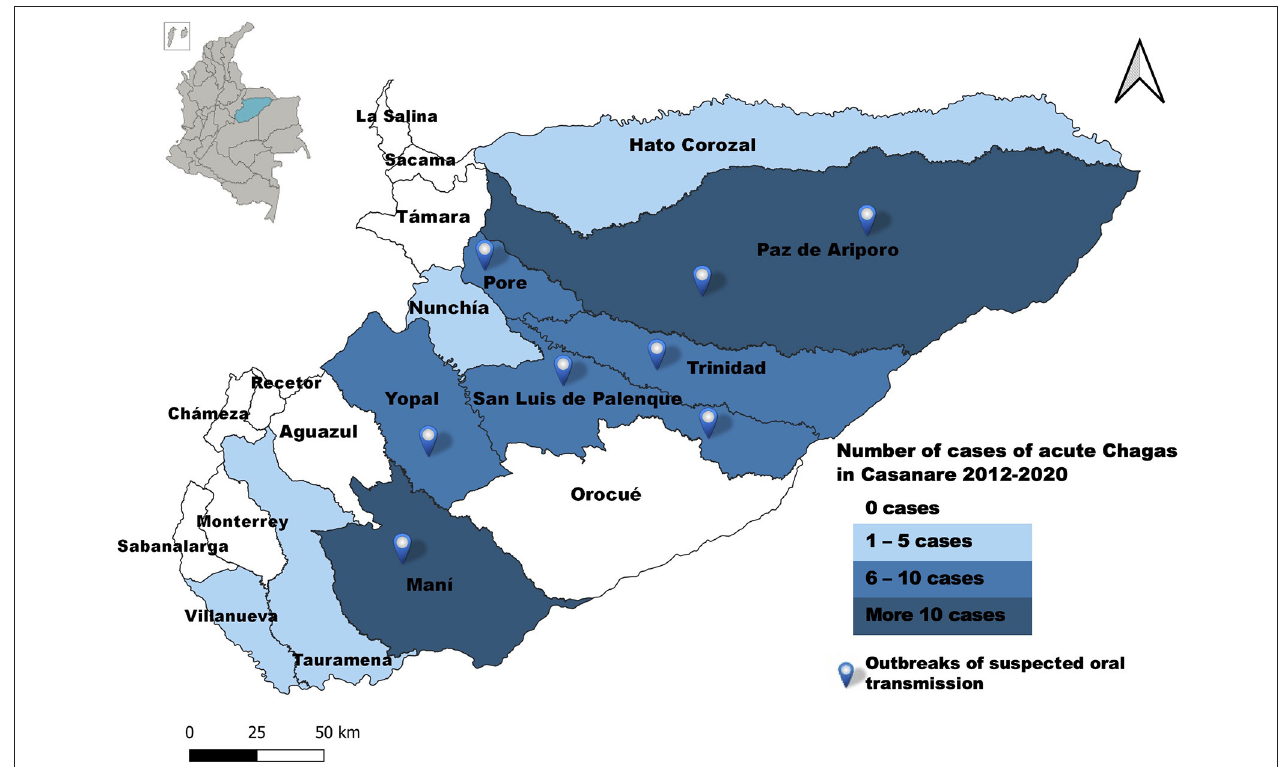
FIGURE 2 | Geographic distribution, acute Chagas disease by municipality of origin, Casanare